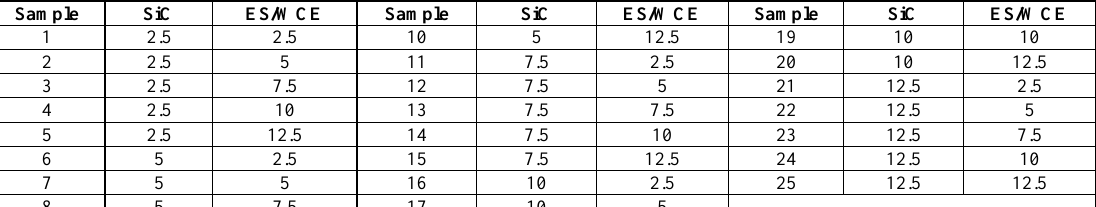
Figure 2. Variation of mechanical properties of different hybrid composites Table 3. Nomenclature and wt.% of the fabricated samples for experiments